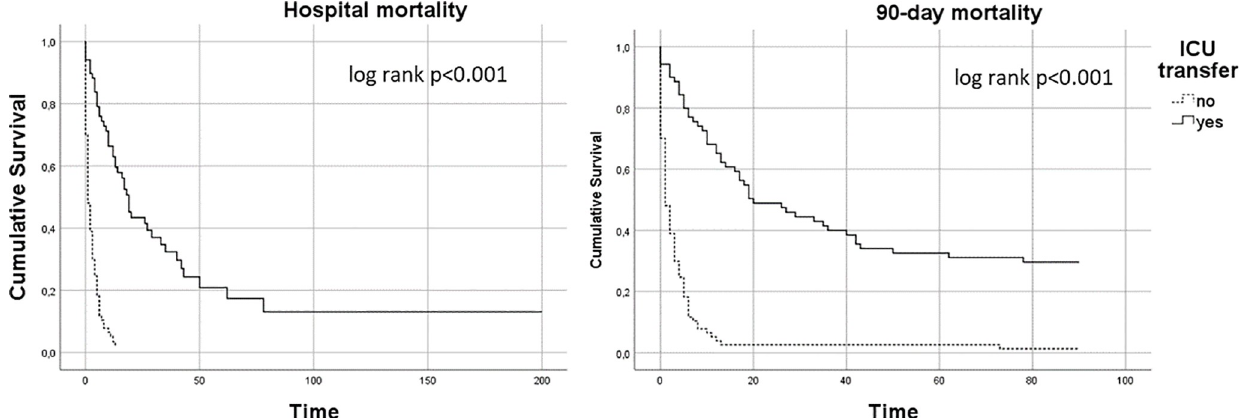
Fig 3. Kaplan Meier survival analysis. The dashed line represents the survival of the patients that were not transferred to the ICU and the continuous line those that were transferred.